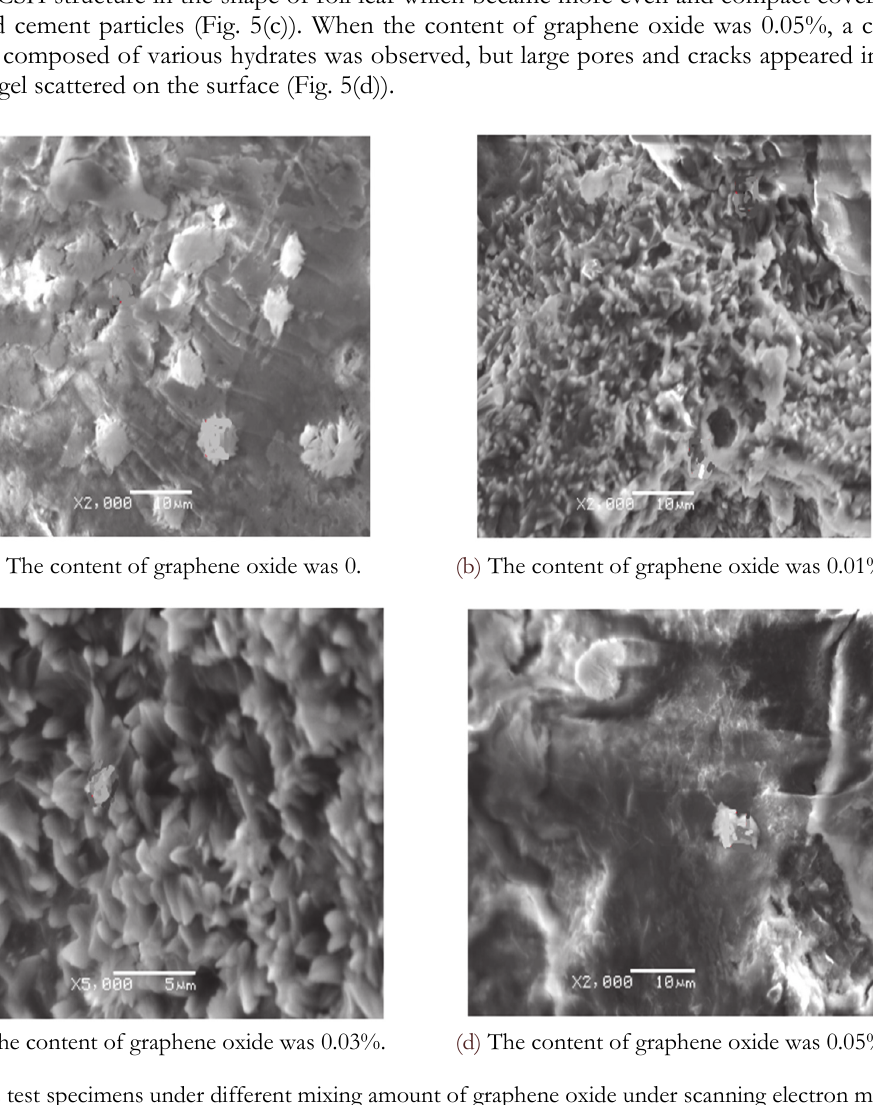
Figure 5: The test specimens under different mixing amount of graphene oxide under scanning electron